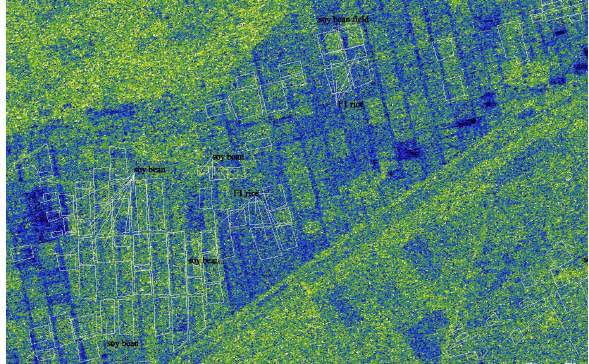
Figure 8. Zooming the RVI result of upper left part of Figure 7. image